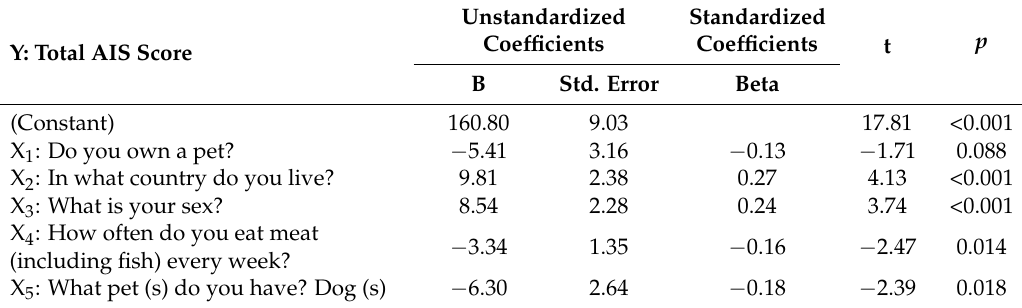
Table 2. Correlations between independent questionnaire variables and the total AIS